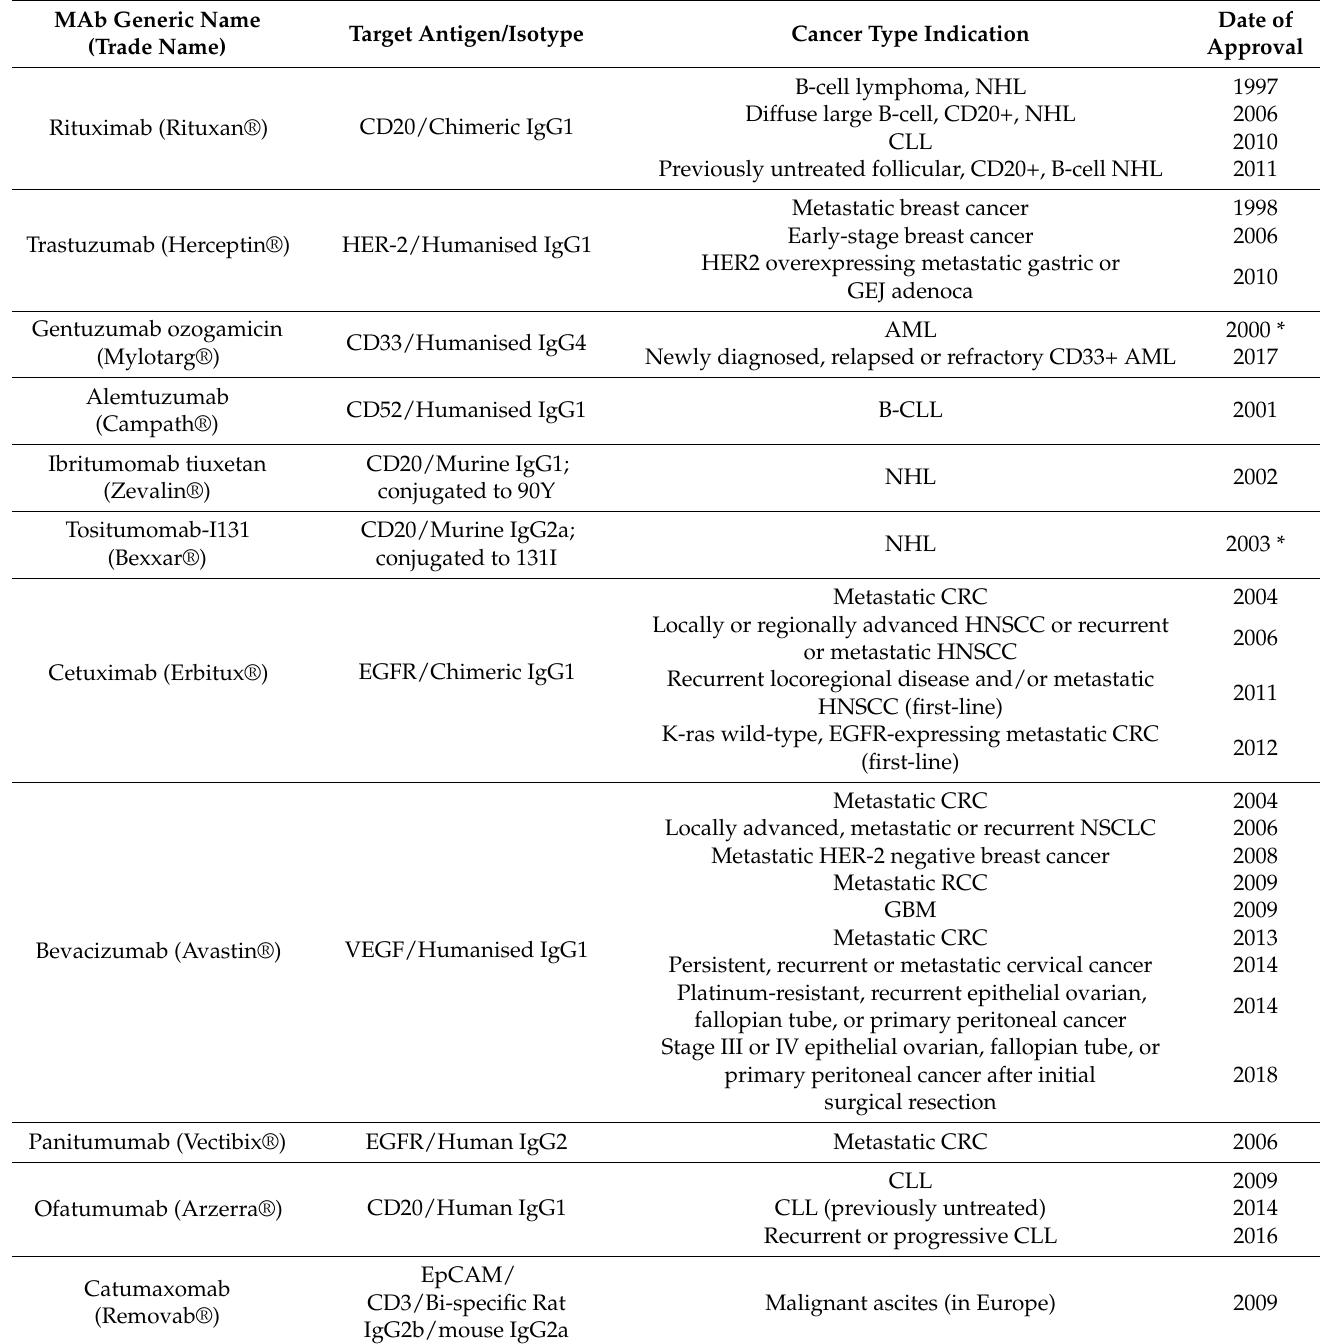
Table 1. Monoclonal antibodies approved in the U.S. and/or European Union for cancer